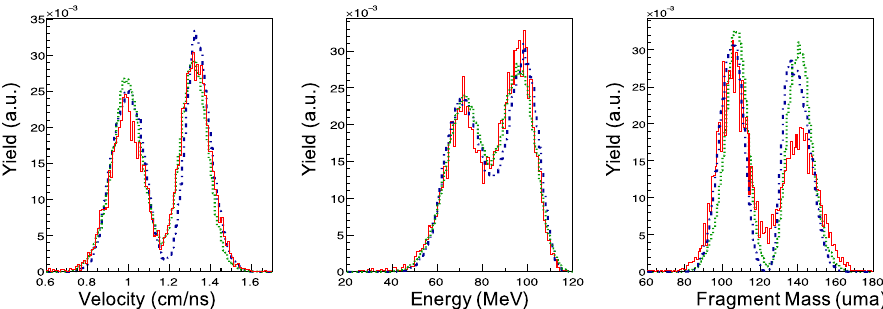
Fig. 2. Velocity (left panel), energy (middle panel) and post-evaporation fragment mass (right panel) distributions for FALSTAFF (red curve) are compared to GEANT4 simulations with two different event generators: FIFRELIN (green dotted curve) and GEF (blue